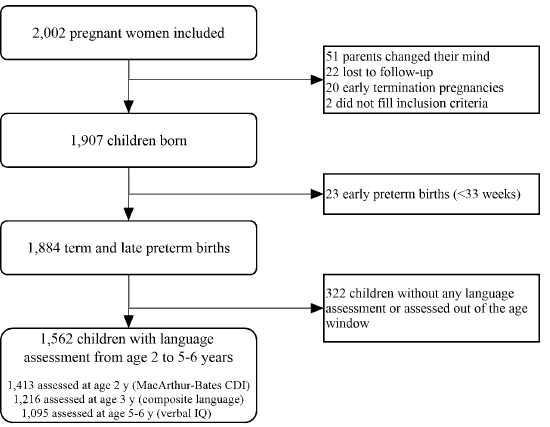
Figure 1. Flowchart of the EDEN participants analyzed in the present study. CDI communicative development inventory, IQ intelligence